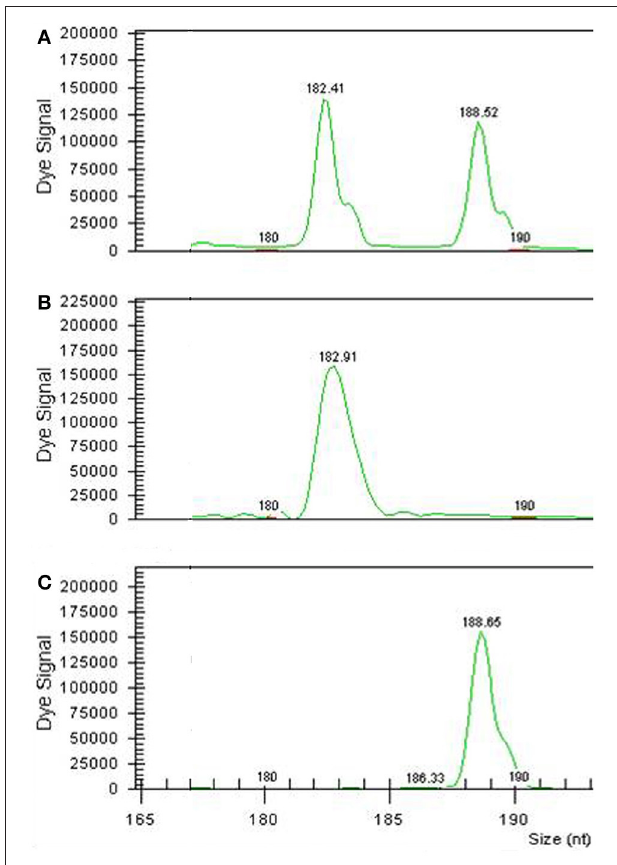
FIGURE 4 | Electropherogram of the chloroplastic SSR marker NTCP7 analyzed in the SMC-58 somatic hybrid (A) and his parents CC (B) and CM (C) Numbers mean the size in nucleotides of each amplified